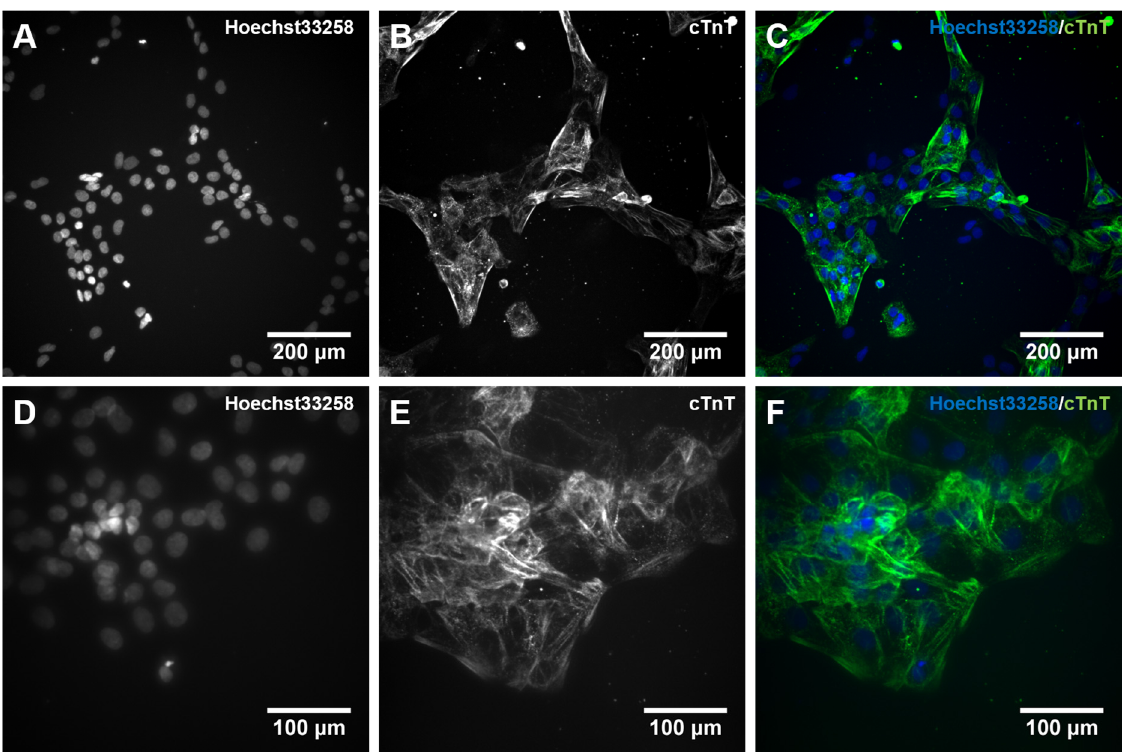
Figure 6. Immunocytochemical (ICC) staining for cardiac muscle Troponin T (cTnT) in 10 days differentiated cardiomyocytes. Human iPSCs were differentiated into cardiomyocytes for 10 days. On day 10, cells were dissociated with Accutase supplemented with 10 µM Y-27632, and 6 × 10 4 cells were plated on a 96-well plate coated with Matrigel (MG). Cells were cultivated for an additional 24 h and subsequently stained with an antibody against cTnT together with Hoechst 33258. ( A , D ): cell nuclei stained with Hoechst33258; ( B , E ): cTnT staining, ( C , F ): merged pictures. The visualization was performed with an automated microscopic system for high content imaging (CellInsight CX7 LZR Platform). Magnification; ( A – C ):100×, ( D – F ): 200×.